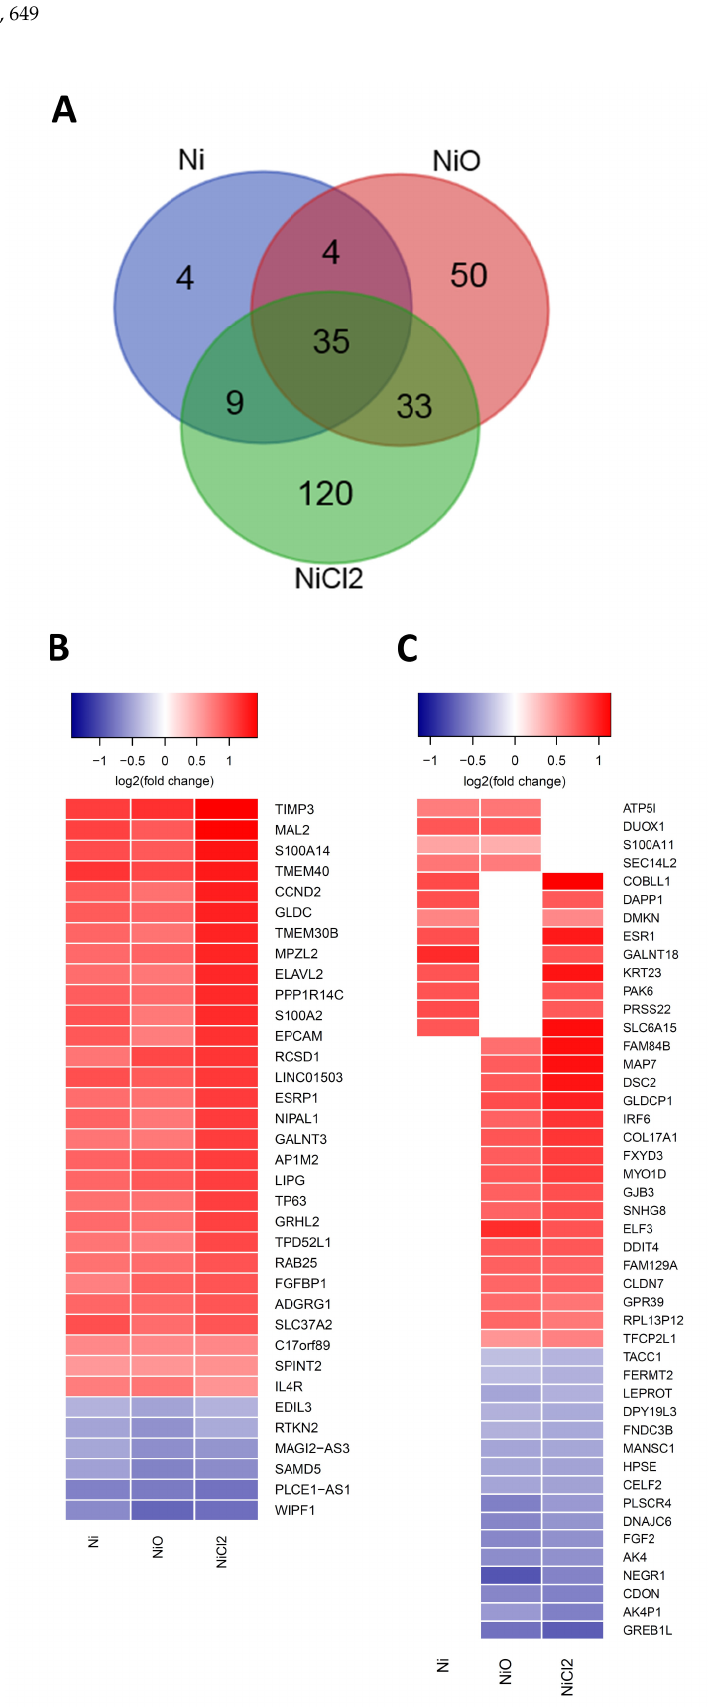
Figure 4. RNA sequencing analysis of the BEAS-2B cells exposed to Ni NPs, NiO NPs or NiCl 2 . ( A ) Venn diagrams of the di ff erentially expressed genes (genes that have a false discovery rate (FDR)-adjusted p -value < 0.05 are considered di ff erentially expressed). ( B ) Heatmap of the di ff erentially expressed genes that overlap between the Ni, NiO and NiCl 2 exposures. ( C ) Combined heatmap of the di ff erentially expressed genes shared between two of the exposures. Color indicates log2(fold